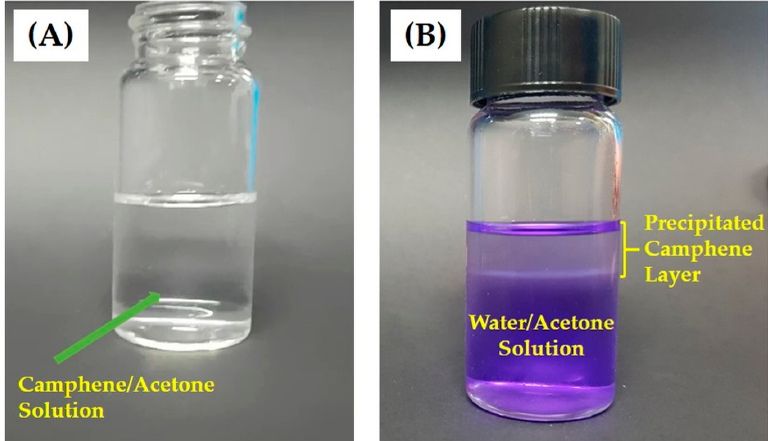
Figure 2. Optical images of ( A ) the camphene–acetone solution and ( B ) the precipitated camphene layer after immersion of the camphene–acetone solution in water. The arrow in Figure 2B indicates the precipitated camphene layer.